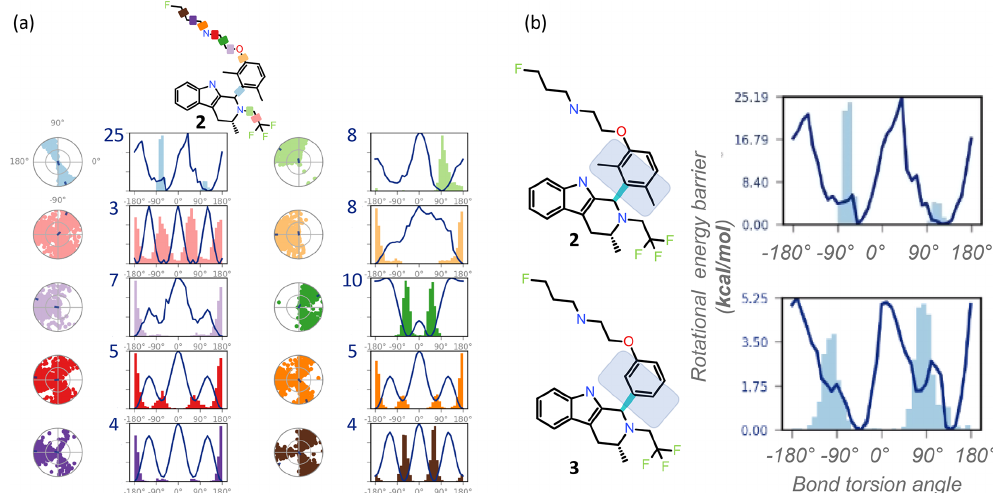
Figure 3. REST-MD visualizations, implemented in Maestro (Schrödinger, 2020b), complement atomic-resolution NMR interpretations of structural dynamics across all bonds. (a) Simulation interaction diagrams report the rotational energy barrier (kcalmol − 1 ) as a function of the bond rotation angle. The conformational space sampled during the simulation is reported either as a function of the simulation time (radial plots, from the center at the start and spiraling outward, with dark dots indicating initial and last sampled dihedral angles) or as histograms superimposed on the torsion energy profiles (kcalmol − 1 vs. bond angle across each color-coded bond in the molecule). Profiles are readily compared between molecular bonds that are pre-organized (light blue with a y -axis maximum in the plot at 25kcalmol − 1 , with a bimodal radial plot and two energy minima), and flexible (pink with 3kcalmol − 1 maximum y -axis value, three energy minima, equally populated, and a randomly populated radial plot). (b) The barrier to rotation of the dimethyl is calculated to be, based on the lower of the two barriers, ∼ 20kcalmol − 1 . Whereas experimentally both energy minima are equally populated as seen by the 1:1 ratio by NMR, the sampling conditions of the rigid “blue” bond were insufficient in the simulation to equally populate both wells. The NMR data in such cases clearly inform on the calculated predictions. A separate REST-MD simulation for the des-methyl compound, 3, was a < 6kcalmol − 1 calculated rotational energy barrier for the same “blue” bond, consistent with sharp lines and ready conversions between the two conformers, with a broadened range of torsions, albeit still bimodal.